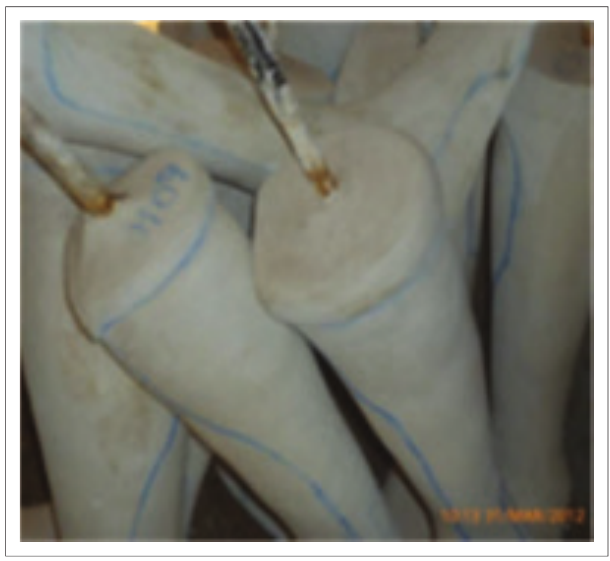
FIGURE 5: Plaster of Paris (POP) positive